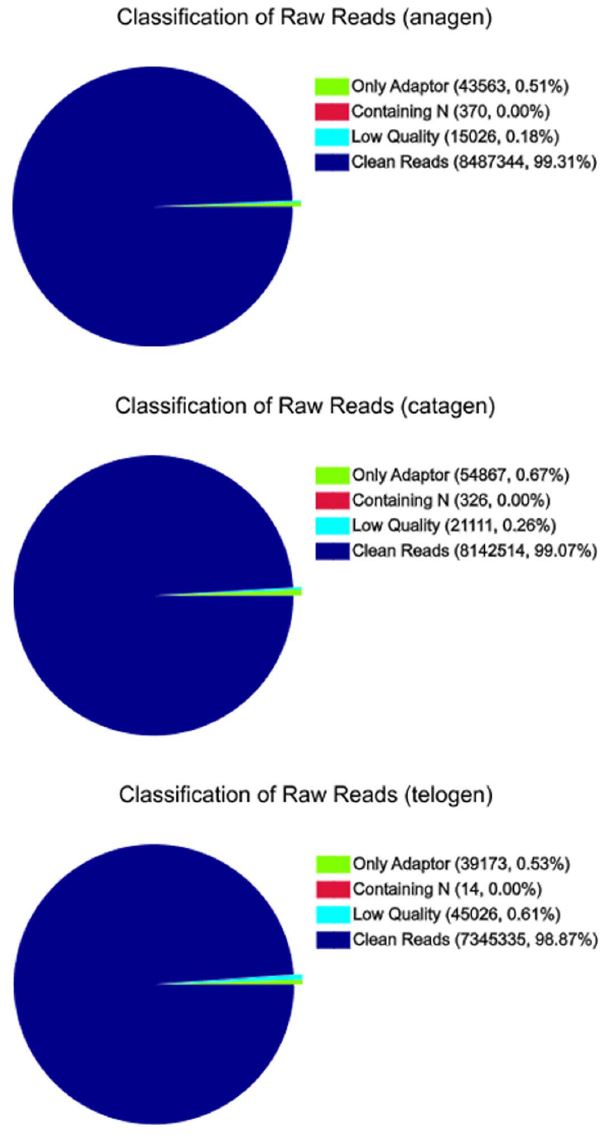
Figure 1. Classification of total raw reads at different developmental stages. After filtering the only adaptor sequences, containing N sequences and low quality sequences, the three RNA-Seq libraries still generated over 7.3 million clean reads in each library, and the percentage of clean reads among raw tags in each library ranged from 98.87% to 99.31%.